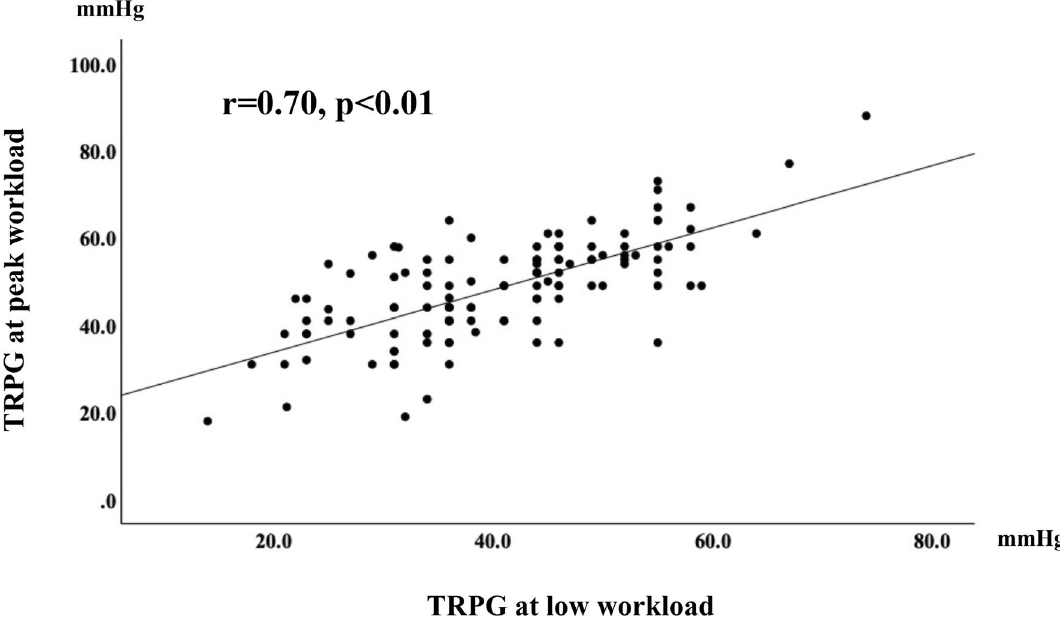
Figure 2. Relationship between TRPG at peak workload and low workload. A significant correlation was found between TRPG at peak workload and TRPG at low workload (r = 0.70, p < 0.001). TRPG tricuspid regurgitation peak gradient.